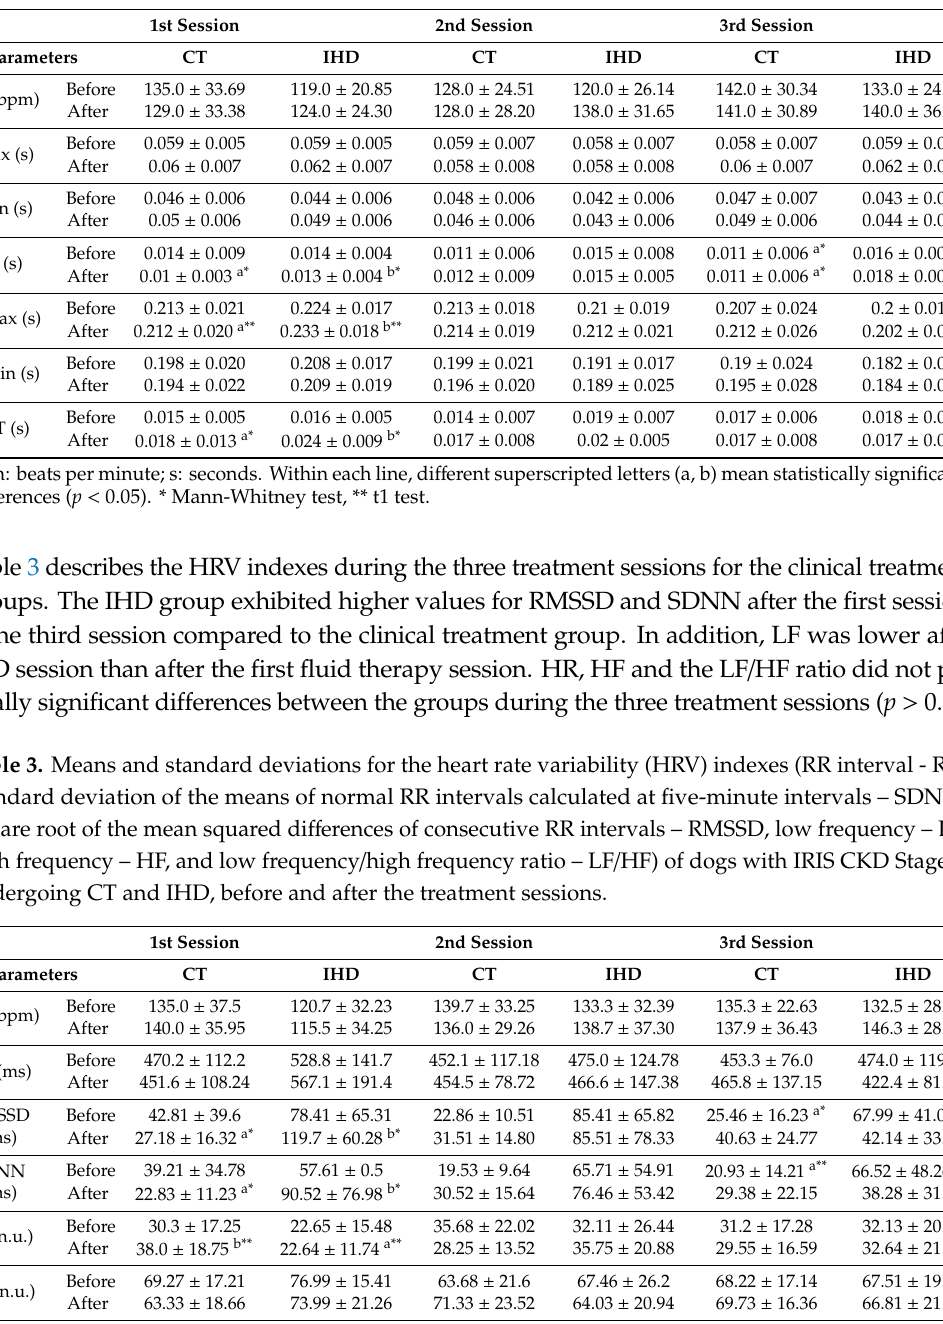
Table 2. Means and standard deviations of the heart rate (HR) and electrocardiographic parameters possible predictive of arrhythmias (P wave maximum, P wave minimum, dispersion of P wave, QT interval maximum, QT interval minimum, dispersion of QT interval) in dogs with IRIS CKD Stage 4 undergoing CT and IHD, before and after three treatment sessions.